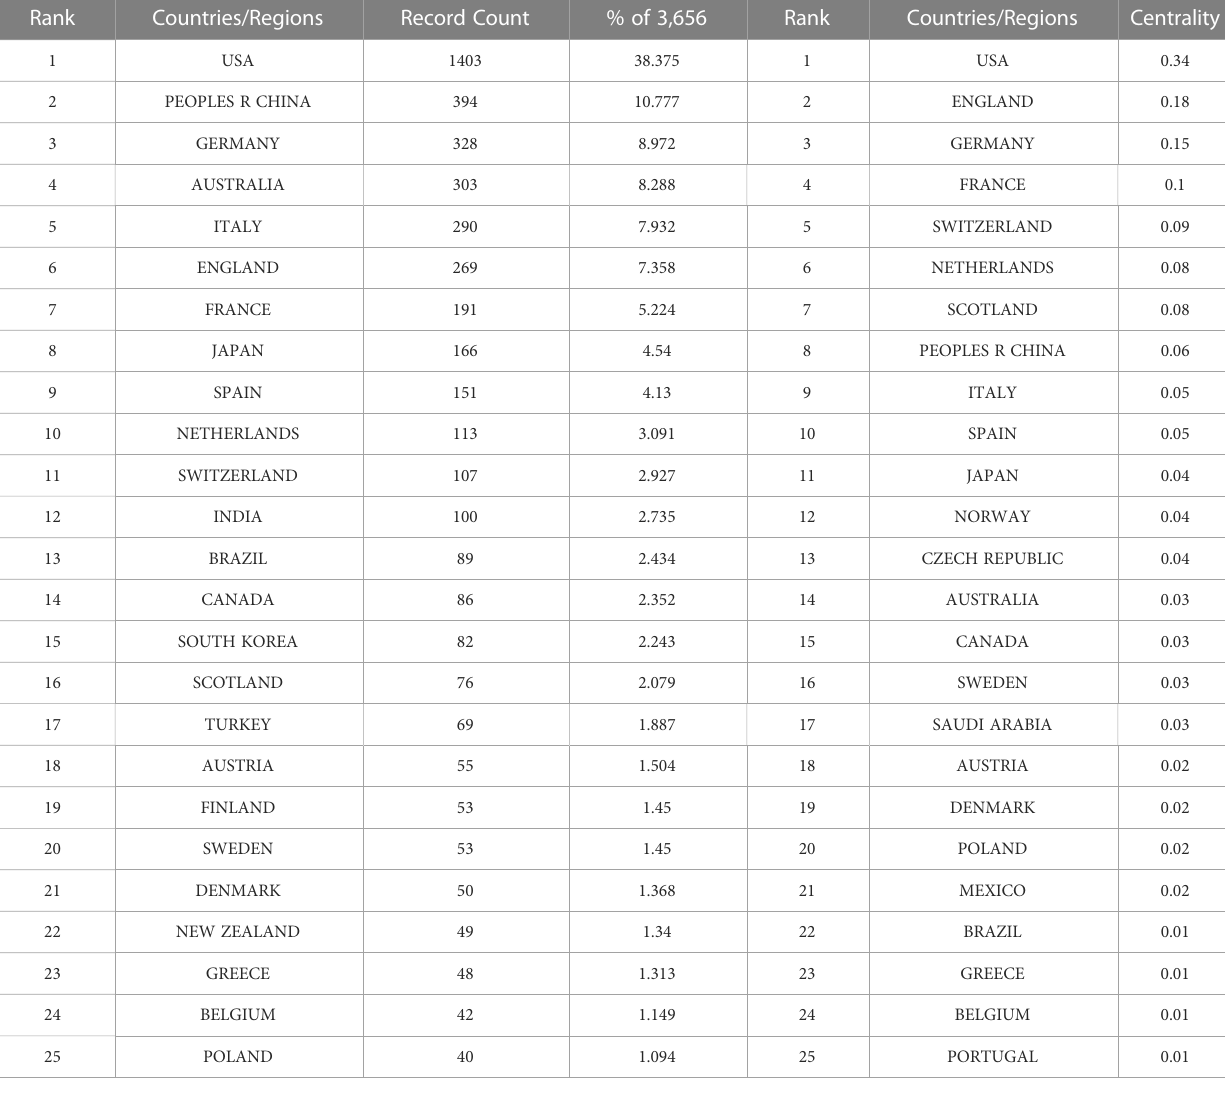
TABLE 2 Number and centrality of published literatures in different countries. Rank